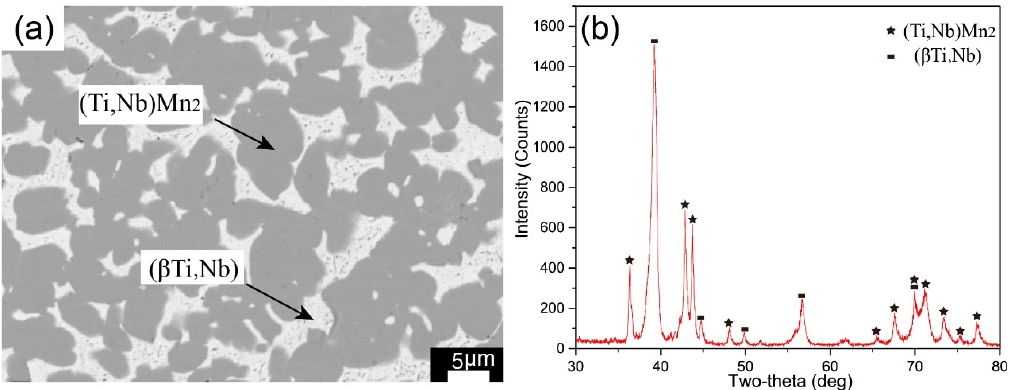
Figure 25. Alloy C7 annealed at 1373K for 40 days: ( a ) BSE images, ( b ) XRD patterns.